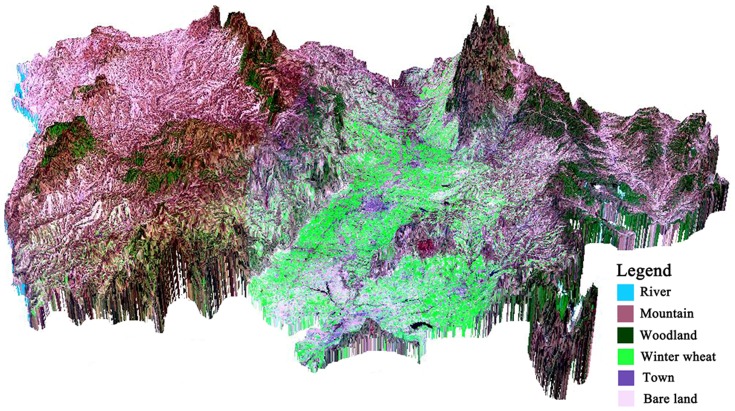
The 3D TM image of remote sensing of Linfen City.